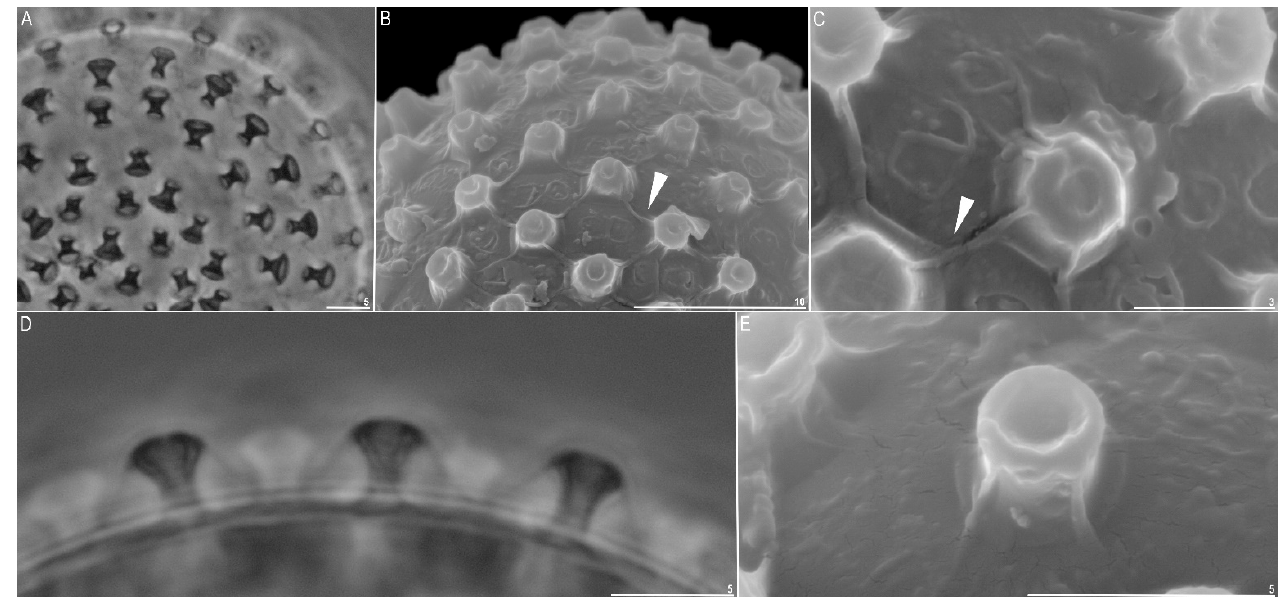
Figure 4. Minibiotus intermedius : ( A ) egg chorion (PCM); ( B ) embryo in the egg (PCM); ( C , D ) egg chorion (SEM). Scale bars in μ m.